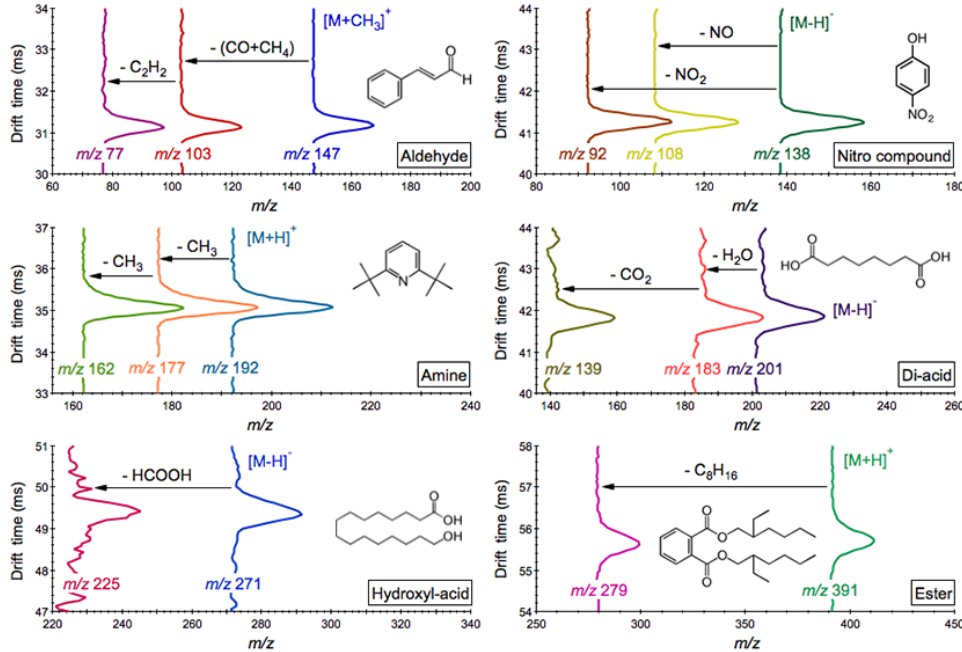
Figure 4. Collision-induced dissociation patterns for molecular ions generated from cinnamaldehyde, dioctyl phthalate, 2,6-di-tert- butylpyridine, 4-nitrophenol, 16-hydroxyhexadecanoic acid, and sebacic acid on the 2-D framework with mass-to-charge ratio on the x axis and drift time on the y axis. The corresponding mobility-selected MS spectra for each species is given in Fig.